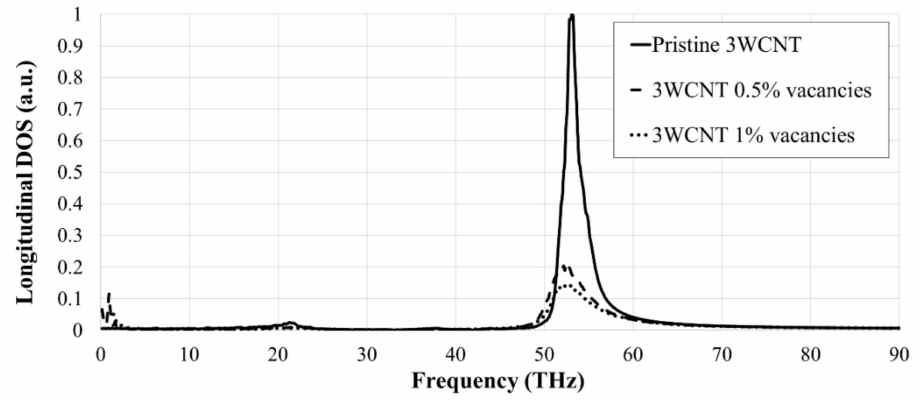
Figure 3. Normalized phonon density of states (PDOS) curves for 3WCNTs with various vacancy